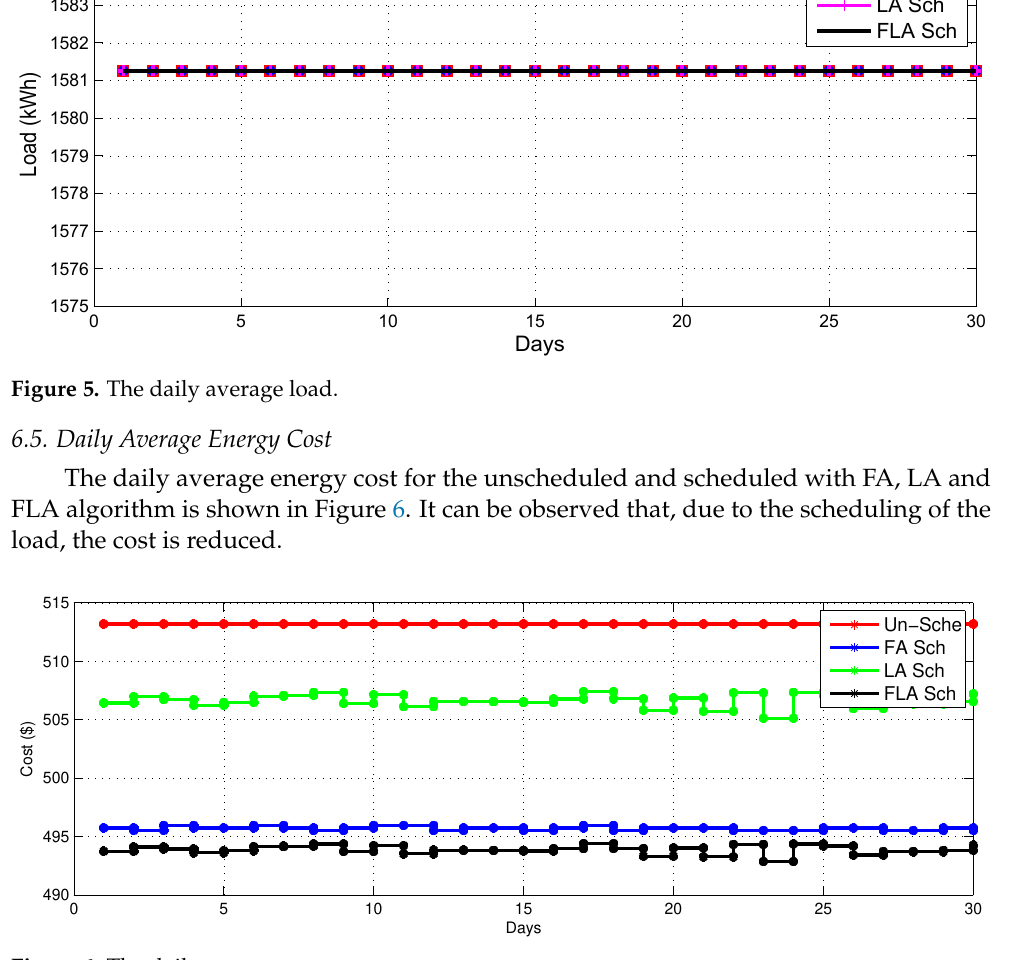
Figure 6. The daily average energy